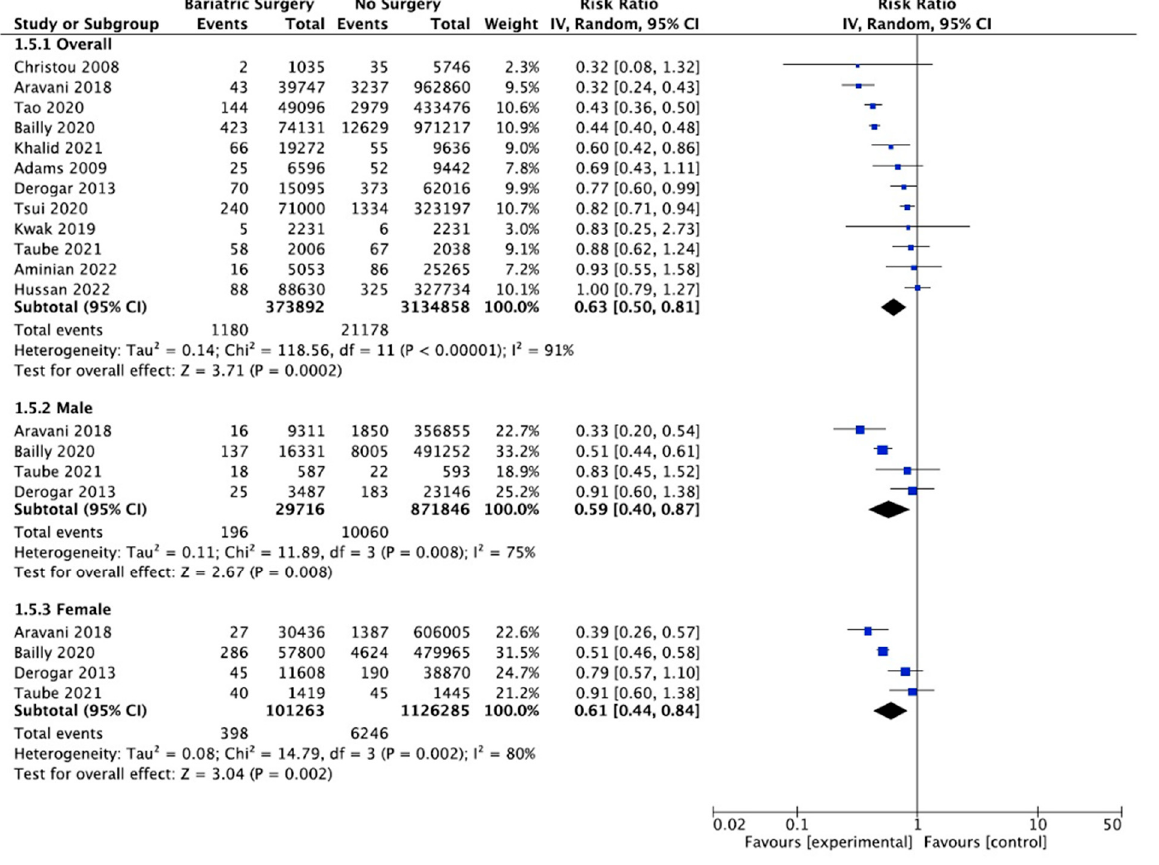
Figure A21. Future CRC risk incidence. Forest plot with Mackenzie et al. [45] data removed from the overall and subgroup CRC analysis after the sensitivity analysis [38,40,42,43,49,50,58–63].